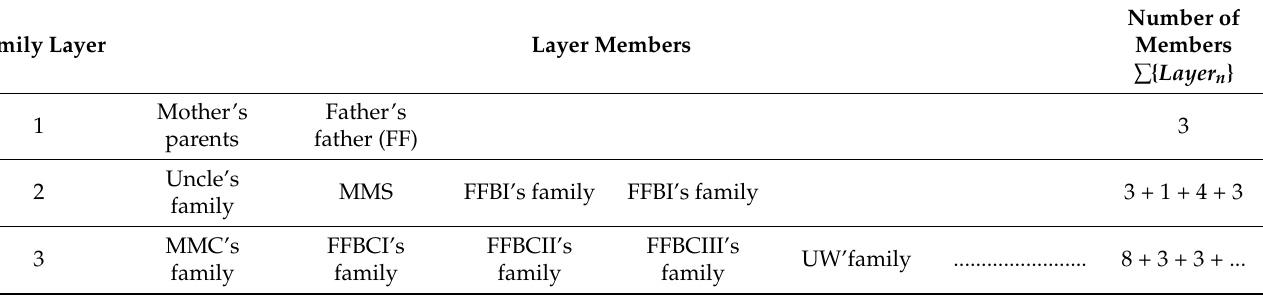
Table 4. Case with family-family